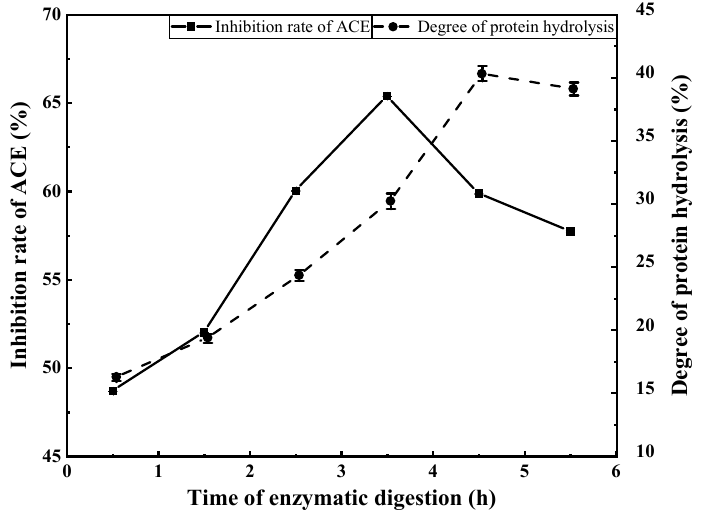
Figure 6. The effect of enzymatic digestion time on the inhibition rate of ACE and the degree of protein hydrolysis.